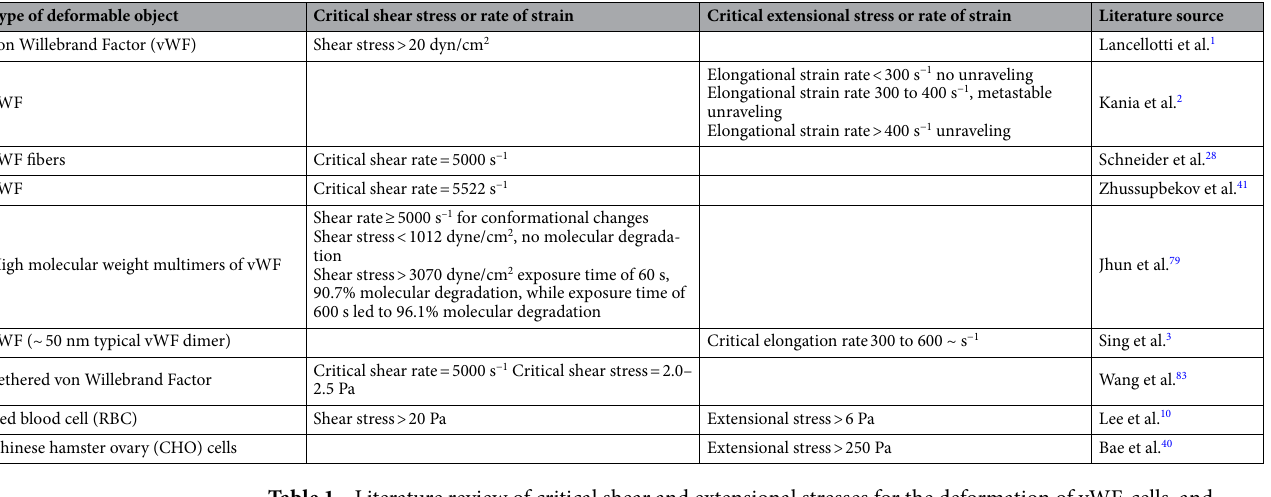
Table 1. Literature review of critical shear and extensional stresses for the deformation of vWF, cells, and